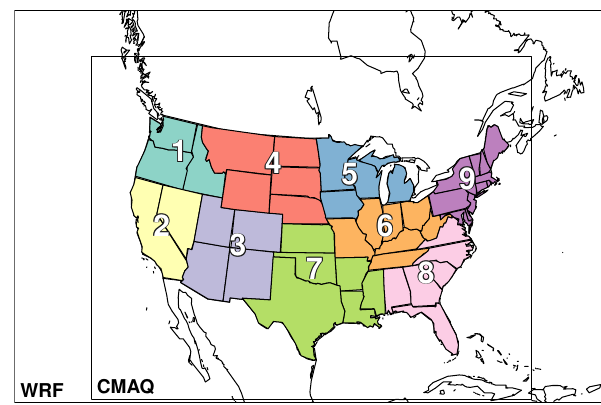
Figure 1. WRF and CMAQ modeling domains, with colored ar- eas representing the National Centers for Environmental Informa- tion (NCEI) US climate regions used for evaluation: (1) Northwest, (2) West, (3) Southwest, (4) Northern Rockies and plains, (5) Upper Midwest, (6) Ohio Valley, (7) South, (8) Southeast, and (9) North-